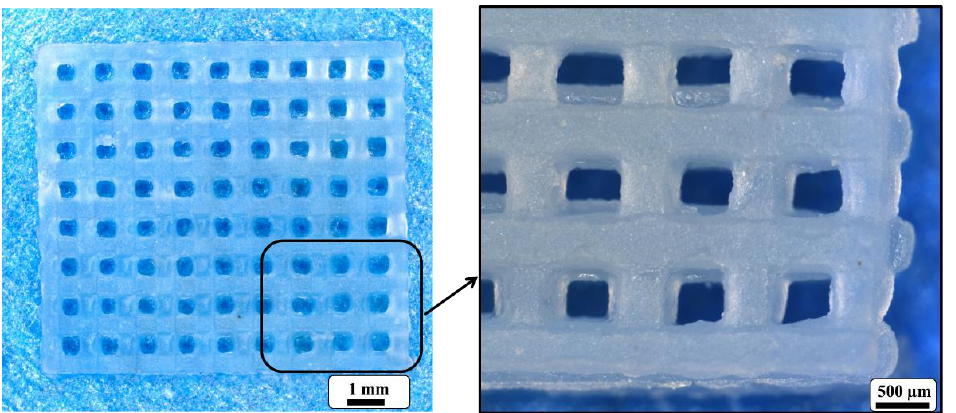
Figure 10. Test prints of a mesh using optimal settings for SAM from the Taguchi analysis of the print parameters.